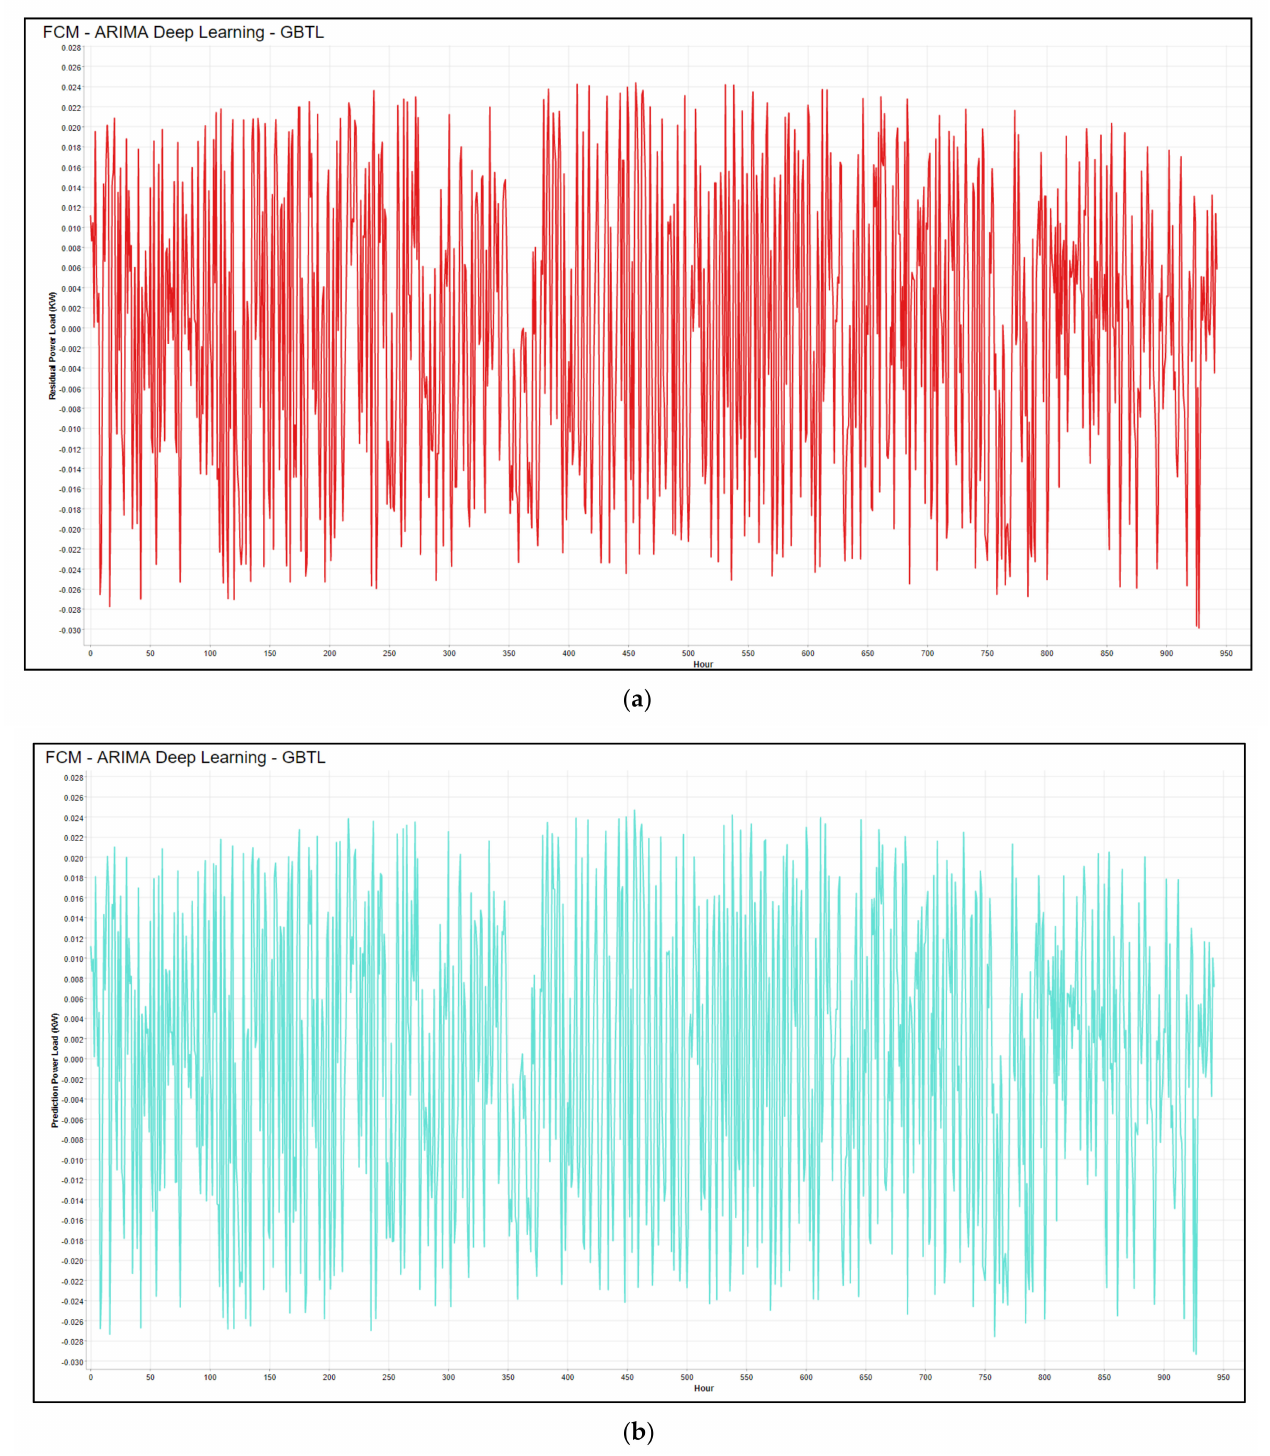
Figure 19. ( a ) The Actual Load (KW) of Cluster 0; ( b ) The Forecasting Load (KW) of Cluster 0. The observations from Figure 19a,b show a perfect match between the actual load and the forecasting load, and this is an indication of the high accuracy of the proposed mode, and that the dependence on external factors such as weather conditions enhance the improvement of the forecasting model